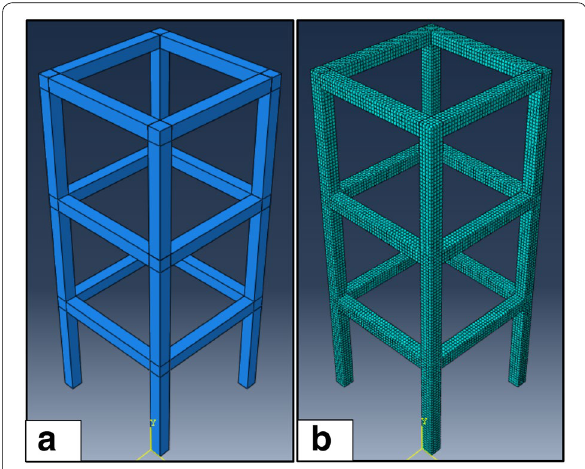
Fig. 15 FEM for seismic analysis. a FEM, b discretization.